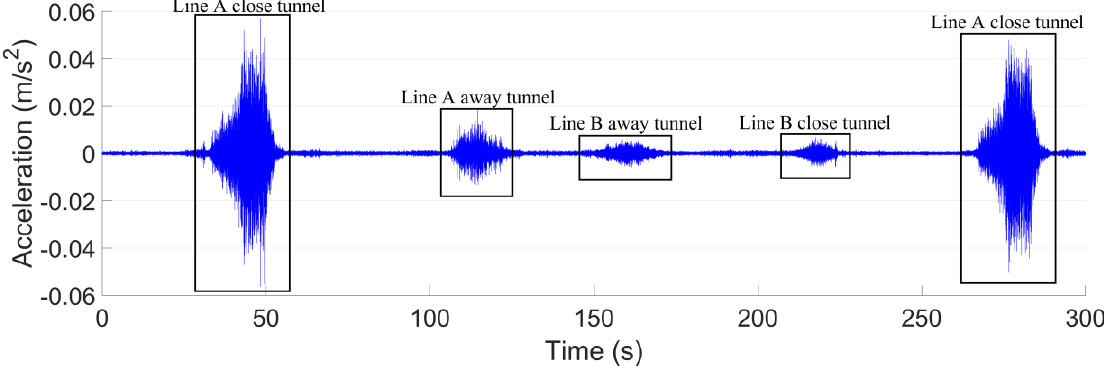
Figure 7. Ground vibration responses measured in test point P1.